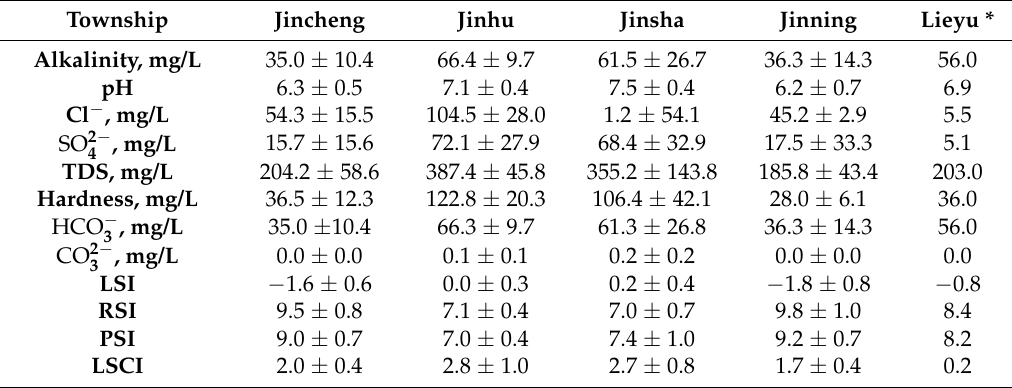
Table 5. Summary of chemical analysis and the water quality index for tap water in